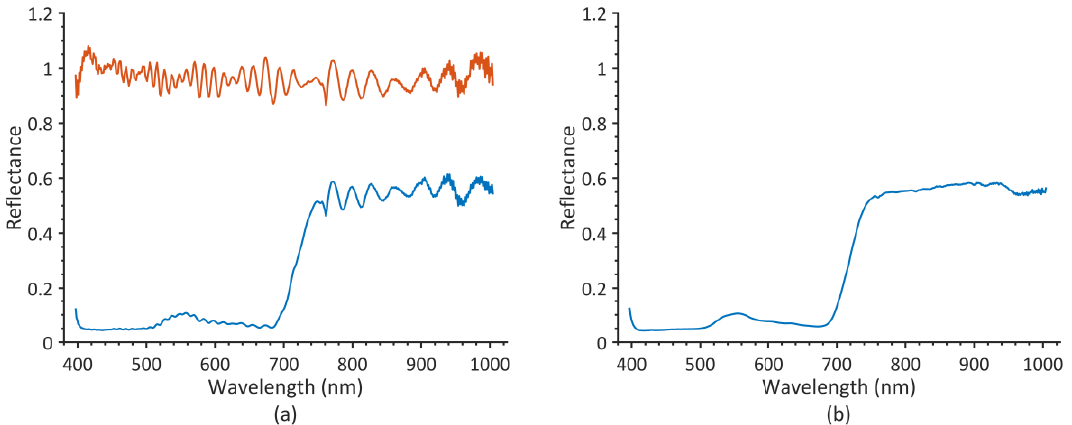
Figure 3. Calculation of reflectance spectra; ( a ) blue line shows the mean spectrum of a tree that results from division by white reference spectrum, red line shows the correction spectrum resulting from “correcting” an image of a white reference panel the same way; ( b ) corrected reflectance spectrum.